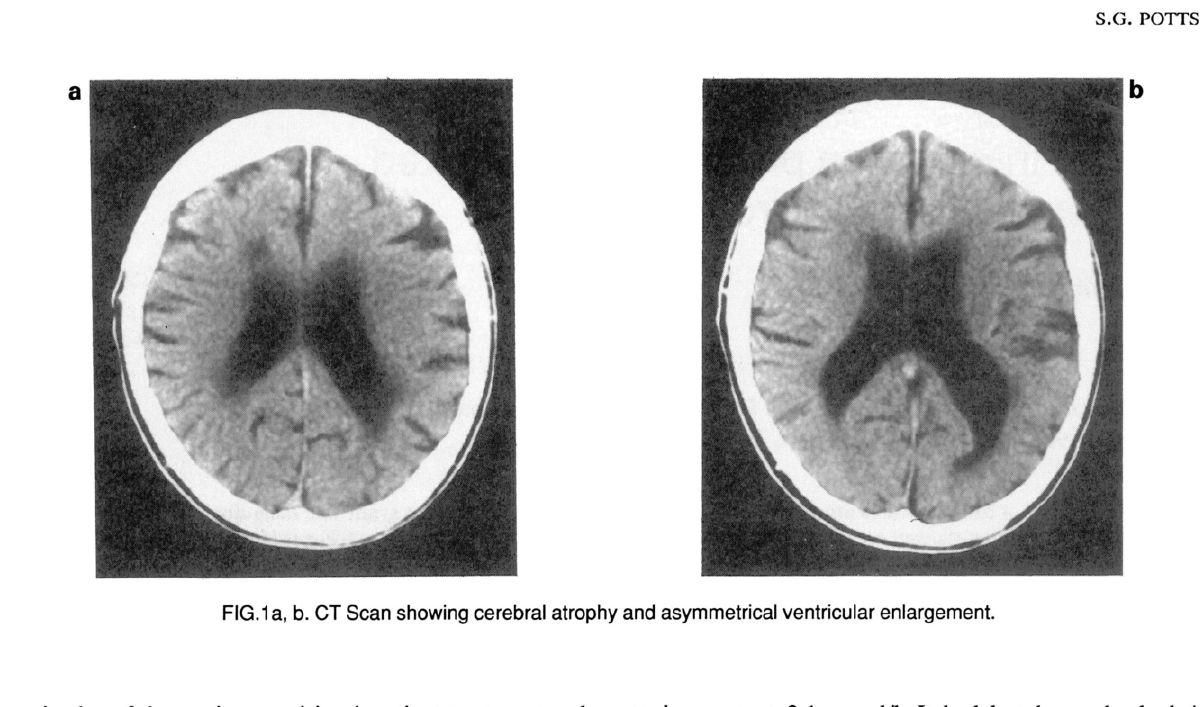
FIG.1 a, b. CT Scan showing cerebral atrophy and asymmetrical ventricular